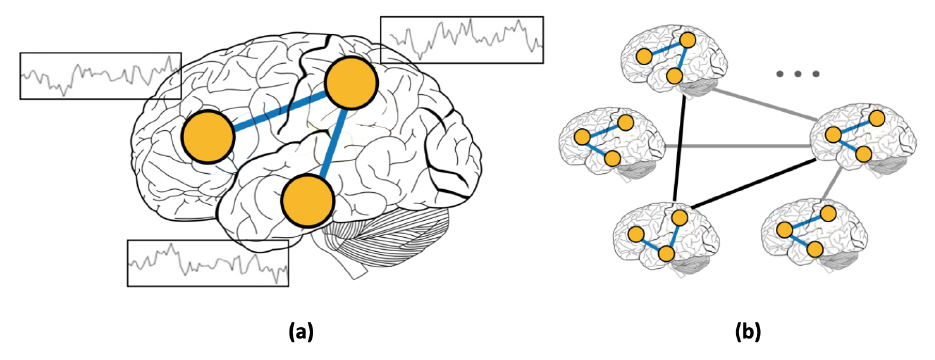
Figure 1. ( a ) Resting-state functional connectivity (RSFC) graph and ( b ) population